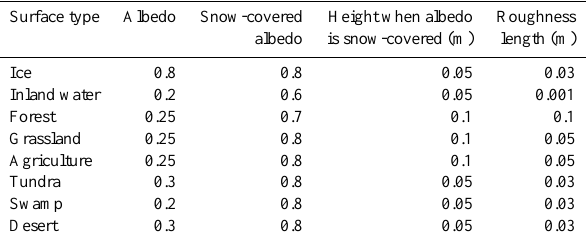
Table 1. Values of surface characteristics for each surface type in IGCM4 (ice, inland water, forest, grassland, agriculture, tundra, swamp, desert). Surface type Albedo